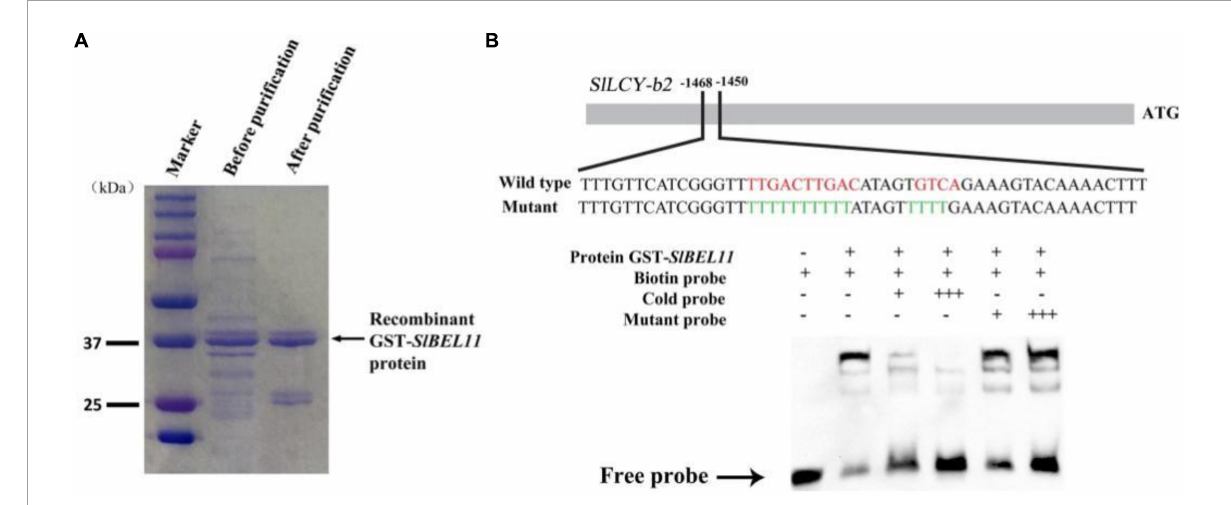
FIGURE3 SlBEL11 bound to the promoter of SlLCY - b2 gene in vitro . (A) Affinity purification of recombinant GST- SlBEL11 protein by SDS-PAGE gel. (B) SlBEL11 bound to the promoter of SlLCY - b2 gene containing TTGACTTGAC atagt GTCA element in EMSA. + and – indicate the presence and absence of the indicated probe or protein,